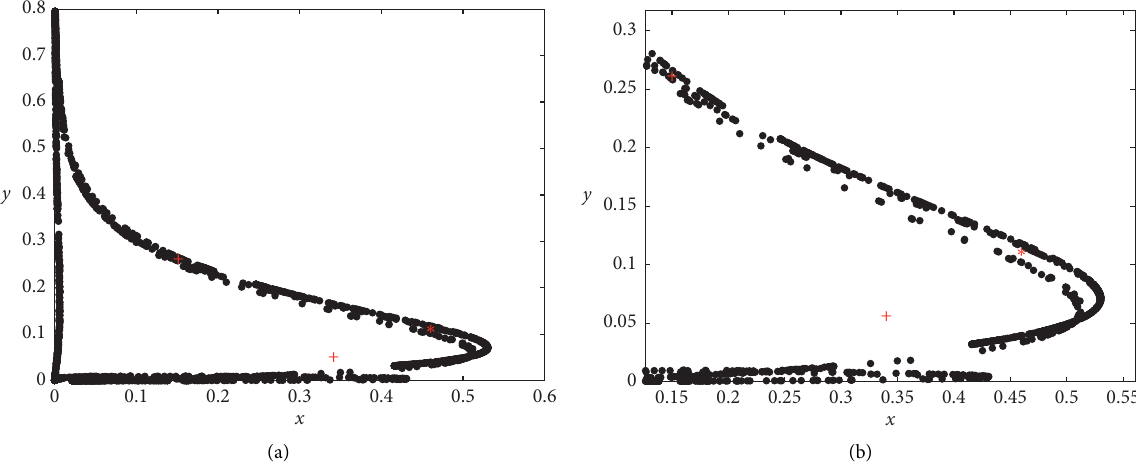
Figure 2: The chaotic attractor of the Hassell mapping with unstable periodic orbits of period-1(.) and period-2(+).